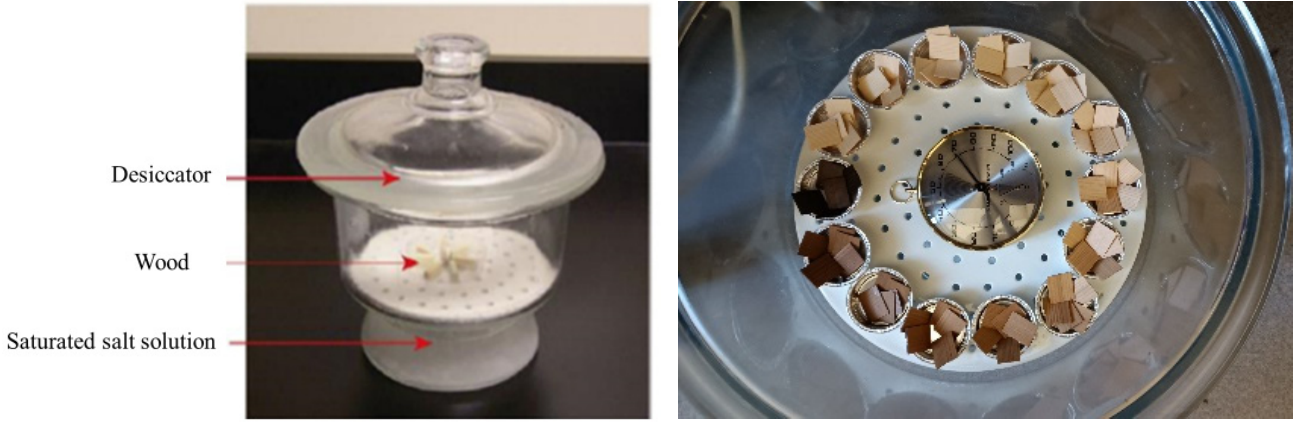
Figure 2. Desiccator used for wood wetting ( left ). Wood samples are placed from low to high heat treatment temperature ( right treatment temperature ( right ).